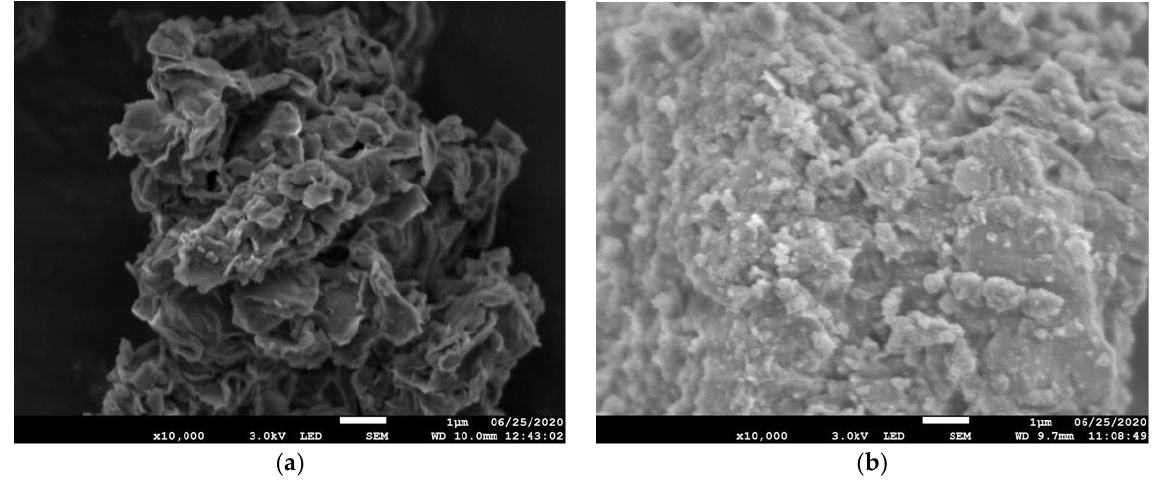
Figure 3. Microscopic analysis of clay materials by SEM: ( a ) bentonite; ( b ) B-Act.